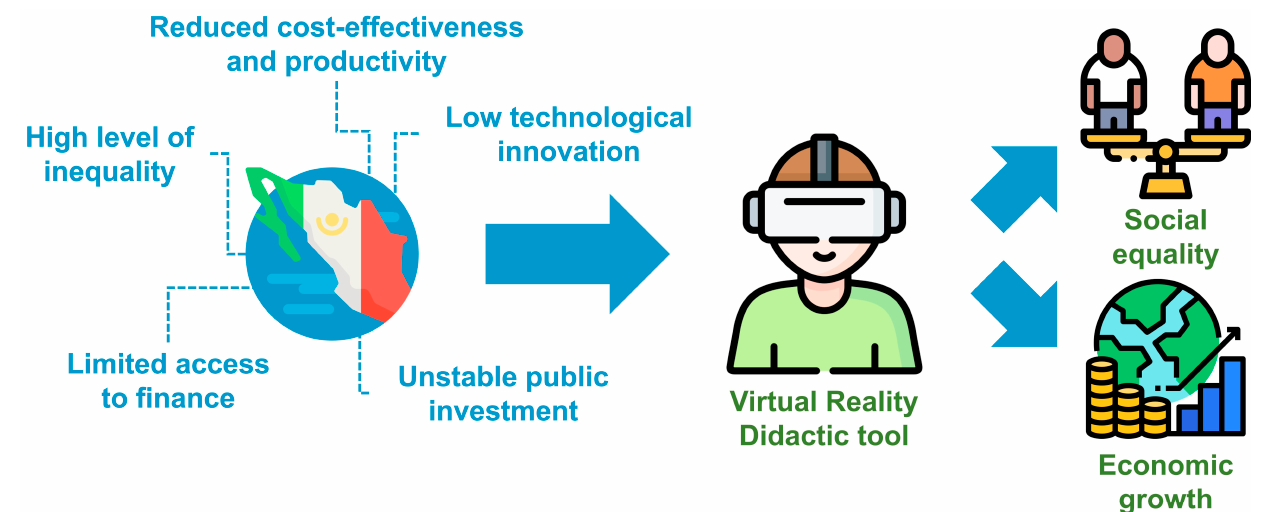
Figure 1. Mexico’s problems and benefits of implementing VR as a teaching tool in the university system.